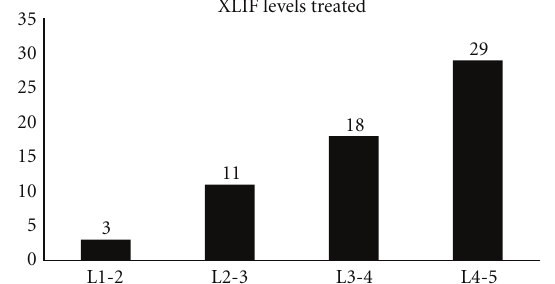
Figure 3: Graph showing the number of each level treated with extreme lateral interbody